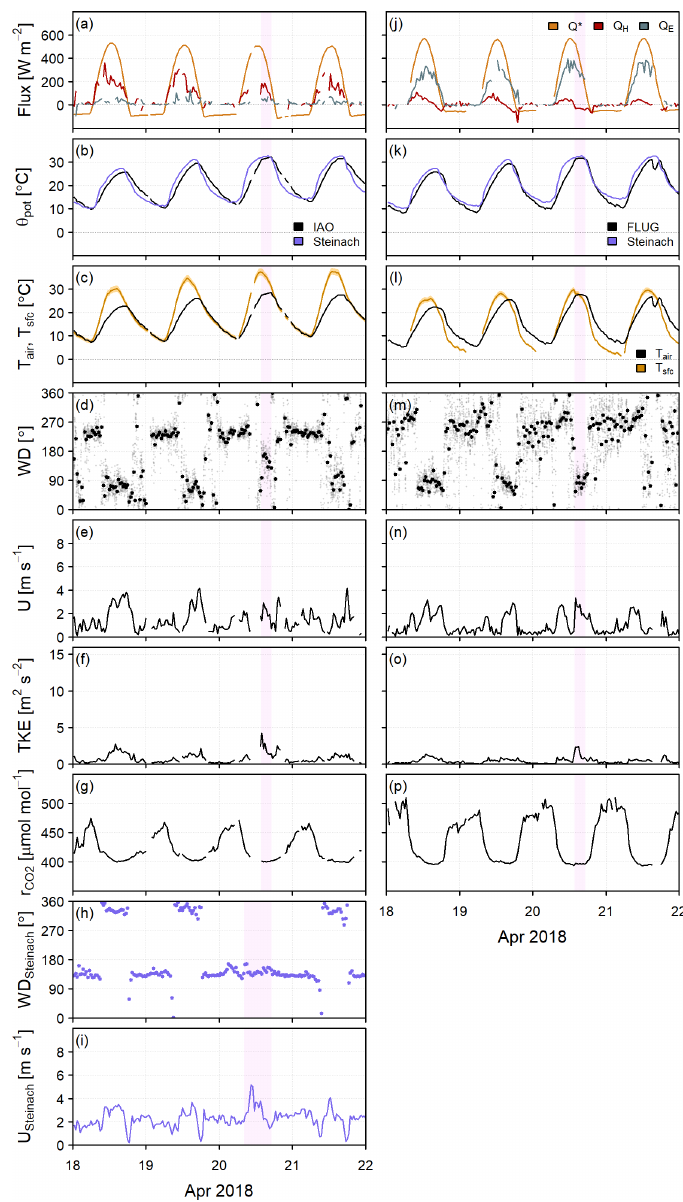
Figure 6. Time series of (a, j) net radiation, sensible heat flux and latent heat flux (b, k) , potential temperature, θ pot , (c, l) air temperature and surface temperature derived from outgoing longwave radiation, assuming an emissivity of 0.95 (shading indicates the uncertainty for emissivities 0.90–1.00), (d, m) wind direction, (e, n) wind speed, (f, o) turbulent kinetic energy and (g, p) CO 2 mixing ratio for the